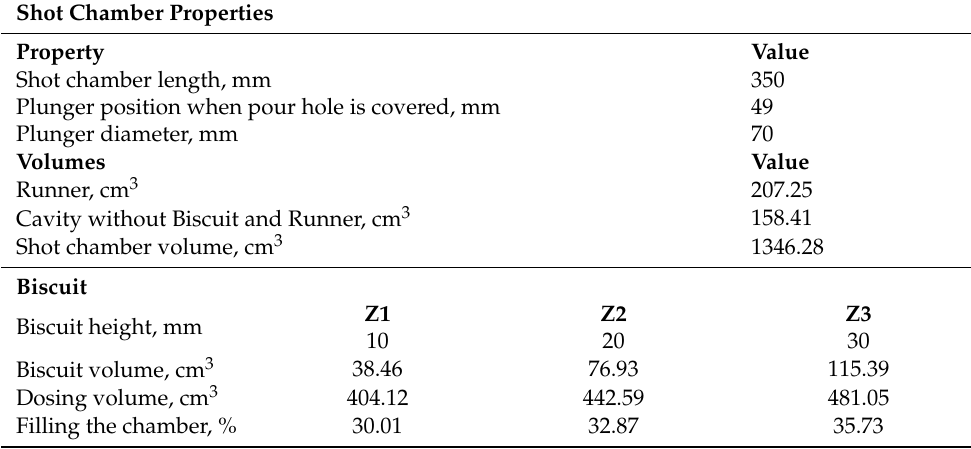
Table 1. Characteristics of the gating system.